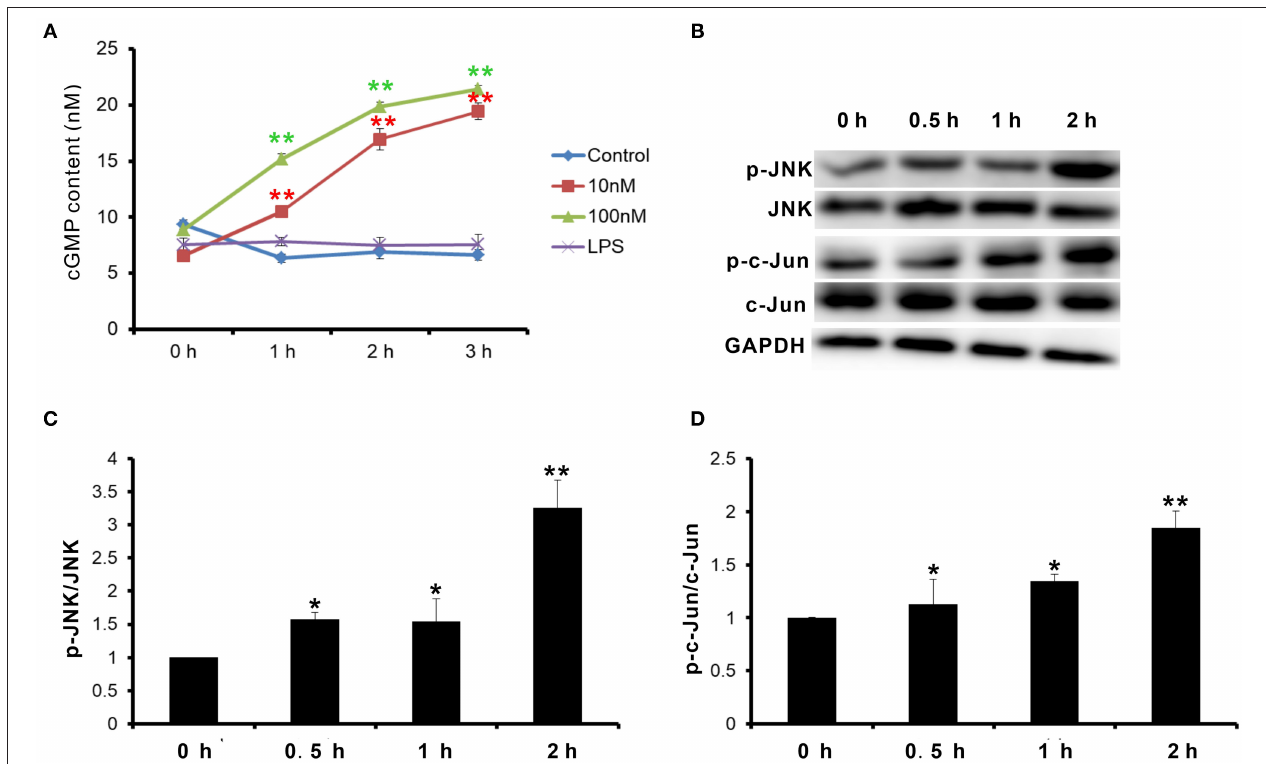
FIGURE 4 | CNP activated NPR-B/c-Jun N-terminal kinase (JNK)/c-Jun signaling pathway in goat MECs. (A) ELISA results showed the cGMP content in goat MECs after treatment by 0 (control), 10, and 100nM CNP or LPS for 0, 1, 2, and 3h, respectively. (B) The phosphorylation levels of JNK and c-Jun in goat MECs after treatment by 0 (control), 10, and 100nM CNP for 0, 0.5, 1, and 2h, respectively, detected by Western blotting. (C) The quantitative analysis results of relative phosphorylation level of JNK in goat MECs after treatment by 0 (control), 10, and 100nM CNP for 0, 0.5, 1, and 2h, respectively. (D) The quantitative analysis results of relative phosphorylation level of c-Jun in goat MECs after treatment by 0 (control), 10, and 100nM CNP for 0, 0.5, 1, and 2h, respectively. * p < 0.05 (compared to control); ** p < 0.01 (compared to control). Full-length blots are given in Supplementary Figures S8–S12